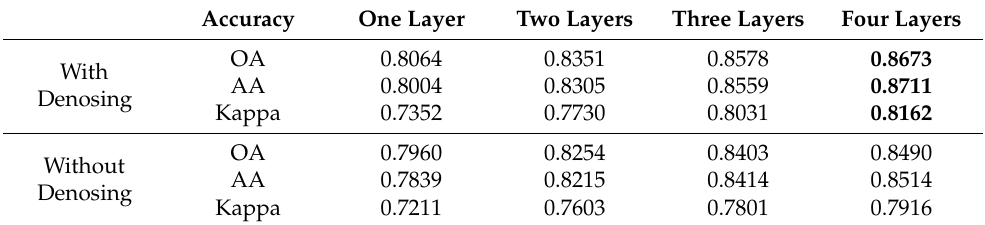
Table 2. Effect of the denoising dual-sparse encoder and network depth.